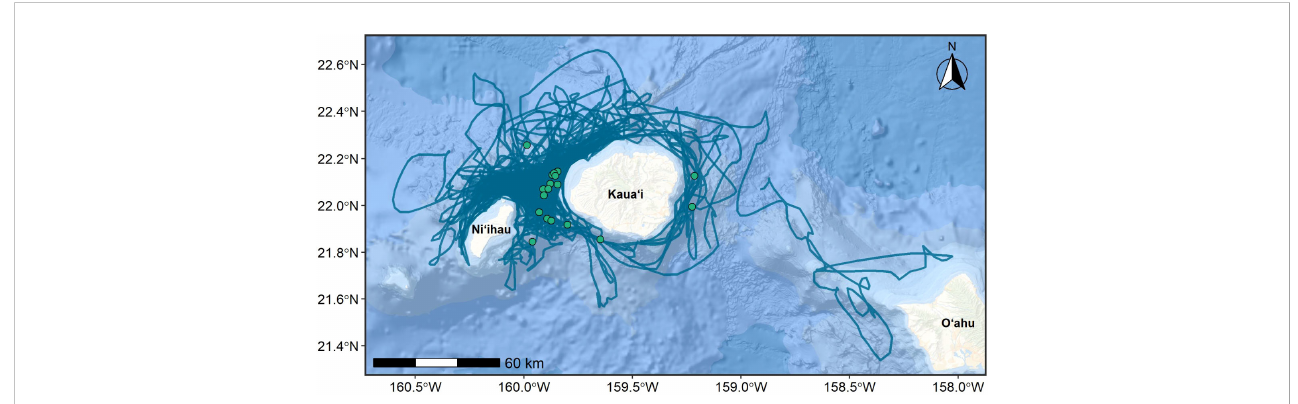
FIGURE 4 Tracklines of hourly crawl positions of satellite tagged rough-toothed dolphins (n=19), re-routed around the 200-m isobath where necessary to avoid tracks crossing land. Tag deployment locations are shown as green circles. Basemap image is the intellectual property of Esri and is used herein with permission. Copyright © 2022 Esri and its licensors. All rights